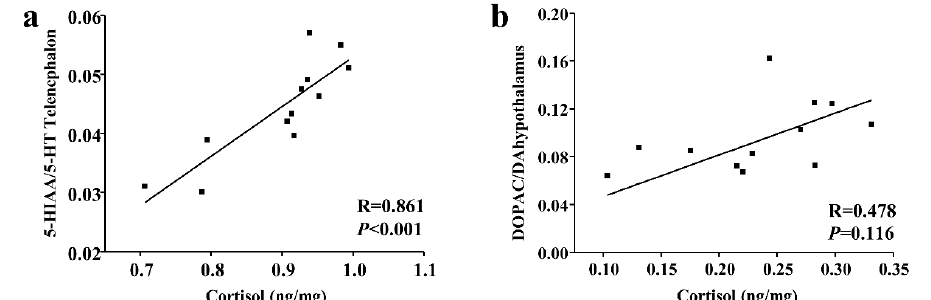
Figure 4. Relationship between cortisol and ( a ) 5-HIAA / 5-HT ratios of subordinate black rockfish in telencephalon and ( b ) DOPAC / DA ratios of dominant black rockfish in hypothalamus after a short-term contest. Spearman R and p values are